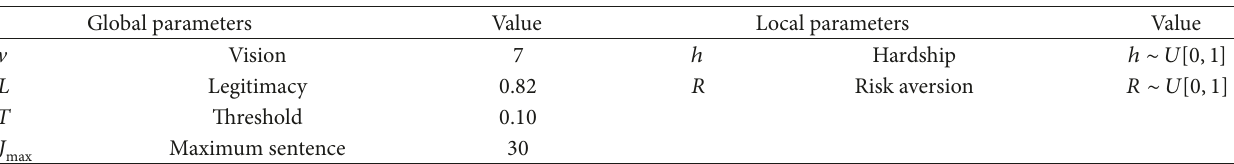
Table 1: Global and local parameters used to reproduce the results reported by Epstein [8]. The size of the grid is (40 × 40) and has toroidal topology, agent density is 0.7, police density is 0.04, and the probability of arrest is 𝑘 = 2.3 . Global parameters Value Local parameters Value